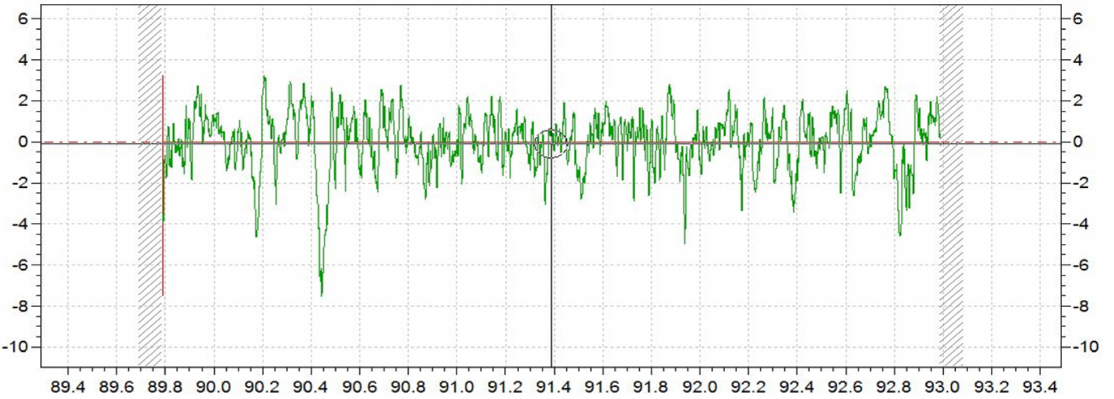
Figure 3. Surface roughness (Rz) of the grinding surface.